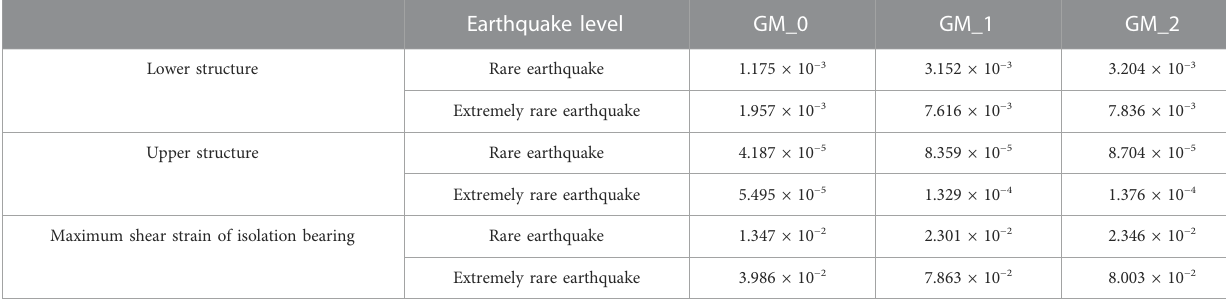
TABLE 4 Failure probability of each substructure of inter-story isolated